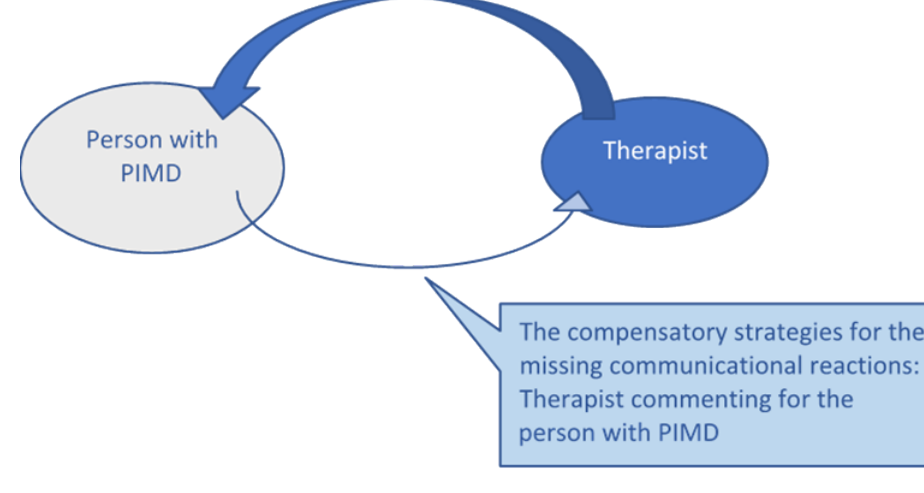
FFigigururee 11 Scheme of verbal interaction based on compensatory mechanisms (Author, 2014).